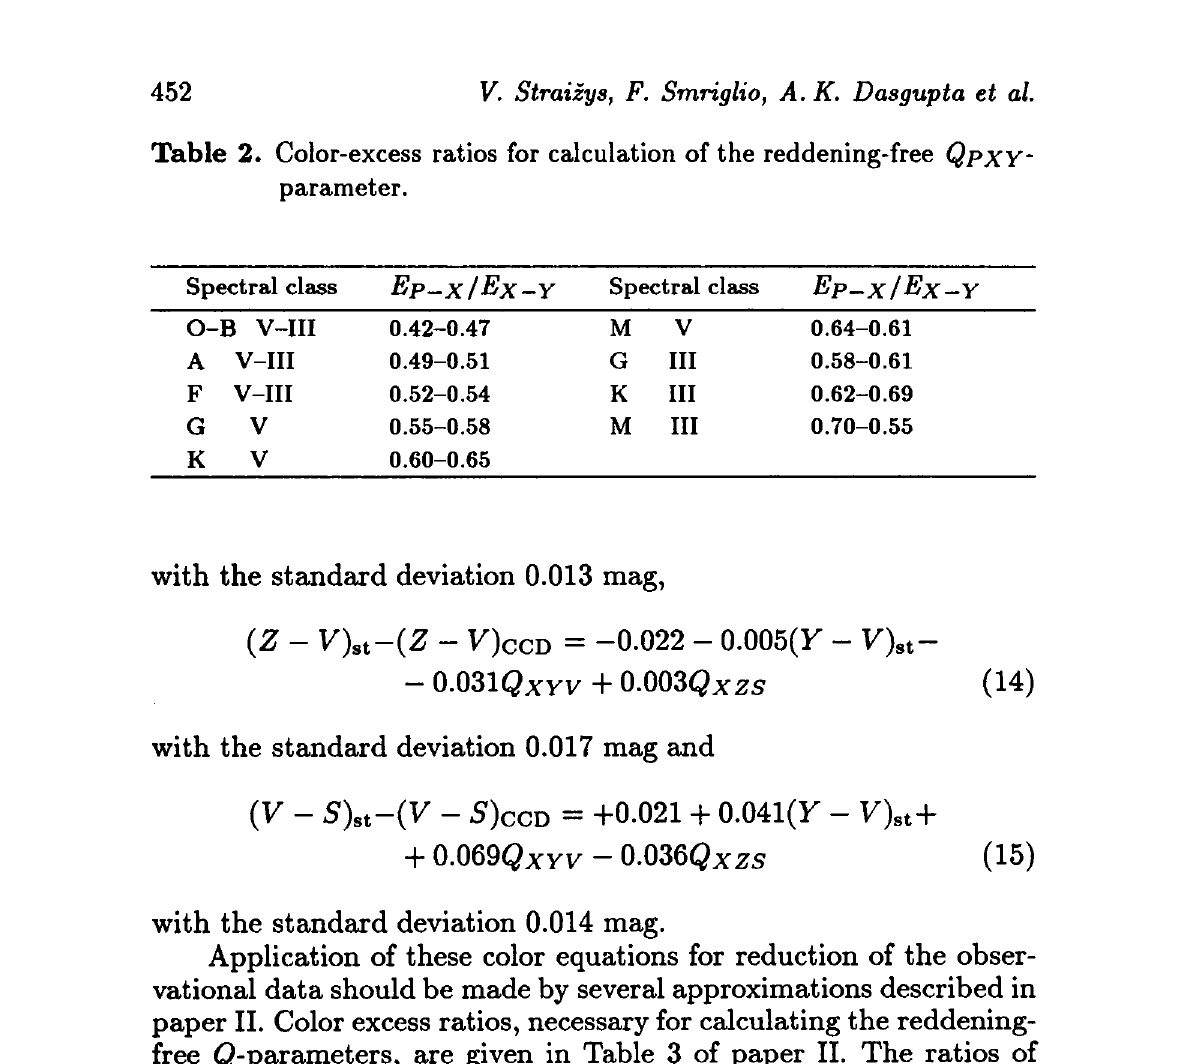
Table 2. Color-excess ratios for calculation of the reddening-free QPXY-